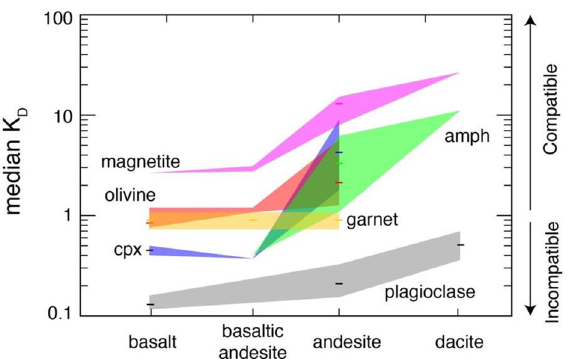
Figure 3. Zn partition coefficient (K D ) values for mineral-melts of different compositions The K D values are reported as median values (coloured ticks) and their 20th and 80th percentile (upper and lower boundaries of the coloured fields). Source data are reported in Supplementary Table